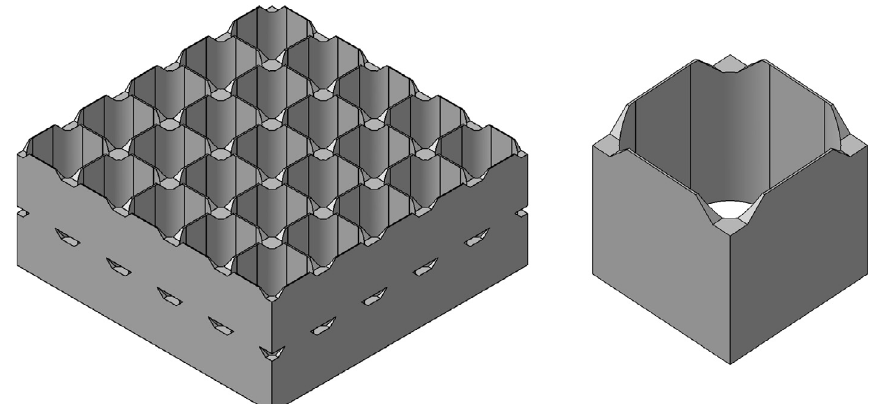
Figure 11. The rebuilt CAD model of periodic resin configuration.